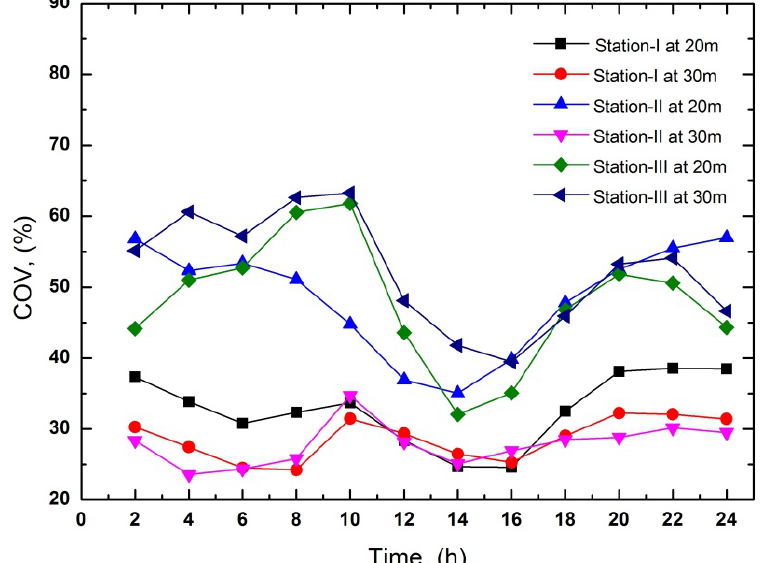
Figure 2. Hourly mean COV of turbulence at 20 m and 30 m